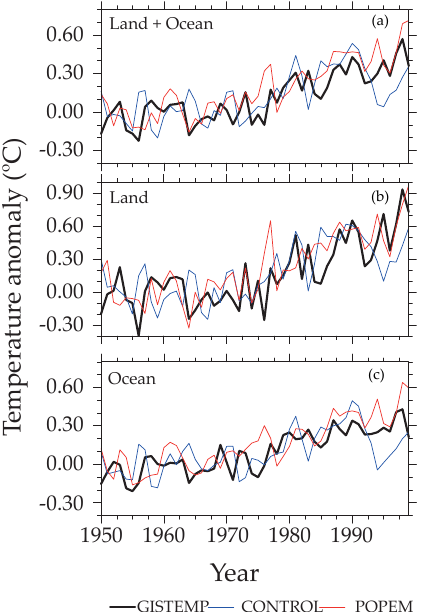
Figure 12. A comparison of the global annual mean surface tem- perature anomaly between GISTEMP, CONTROL, and POPEM from 1950 to 1999. (a) Global, (b) land, and (c) ocean. The black line represents observational data (GISTEMP), the blue line is the CONTROL case, and the red is the POPEM case. Anomaly was referenced to 1951–1980 period.